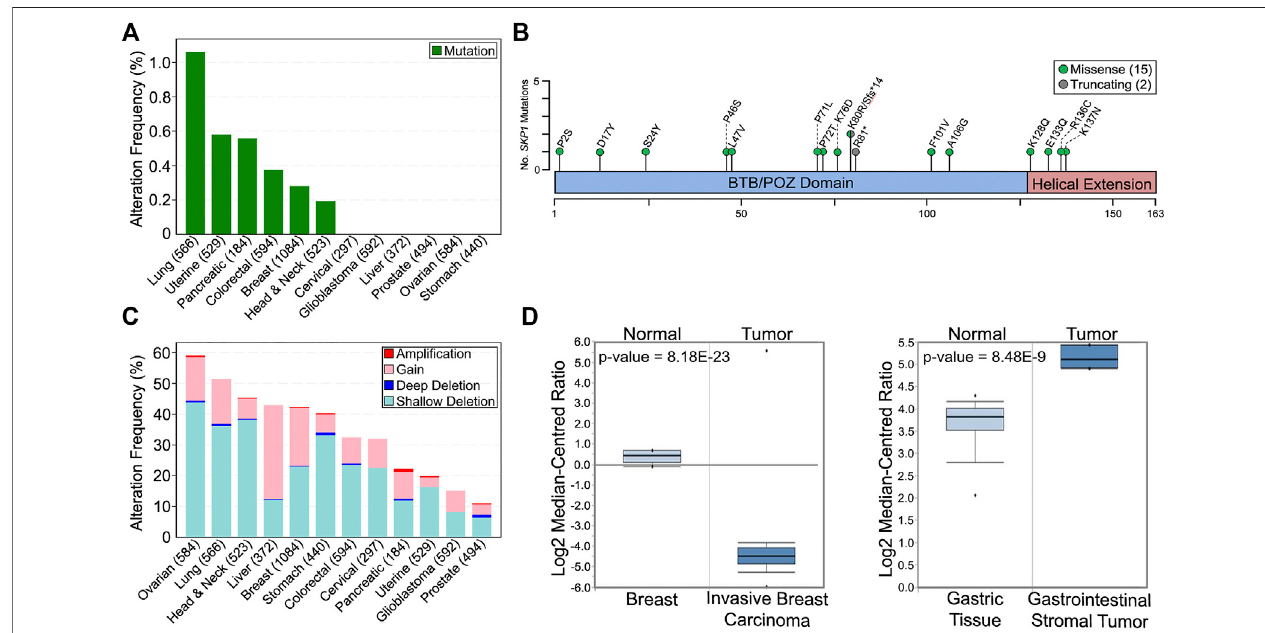
FIGURE2| PrevalenceandImpactof SKP1 AlterationsinCancer. (A) Thefrequencyoftotal SKP1 mutations(missense;truncating;inframe;fusion)in12common, solid tumor cancer types (total cases) (Cerami et al., 2012; Gao et al., 2013). Note that only missense (15) and truncating (2) mutations were identi fi ed from the 12 pan- cancer TCGA datasets (Hoadley et al., 2018). (B) Schematic mapping the positions of the encoded SKP1 mutations across the SKP1 protein using the corresponding single amino acid codes (fs, frameshift; *, premature stop codon). (C) Prevalence of SKP1 copy number alterations (deep deletion; shallow deletion; gain; ampli fi cation) within the 12 common cancer types (total cases) (Cerami et al., 2012; Gao et al., 2013; Hoadley et al., 2018). (D) Box-and-whisker plots displaying SKP1 mRNA expression levels for normal and tumor tissues from invasive breast carcinoma (left) and gastrointestinal stromal tumor (right). Boxes display interquartile range, whiskers denote 10th and 90th percentiles, and the minimum/maximum values are displayed as black dots. Note that a signi fi cant > 25-fold decrease in mean SKP1 expressionoccursininvasivebreastcarcinomarelativetonormaltissue,whileasigni fi cant~3-foldincreaseinexpressionoccursingastrointestinalstromaltumors.Data, graphs and statistical analyses were obtained from the Oncomine database (https://www.oncomine.org) (Rhodes et al., 2007).